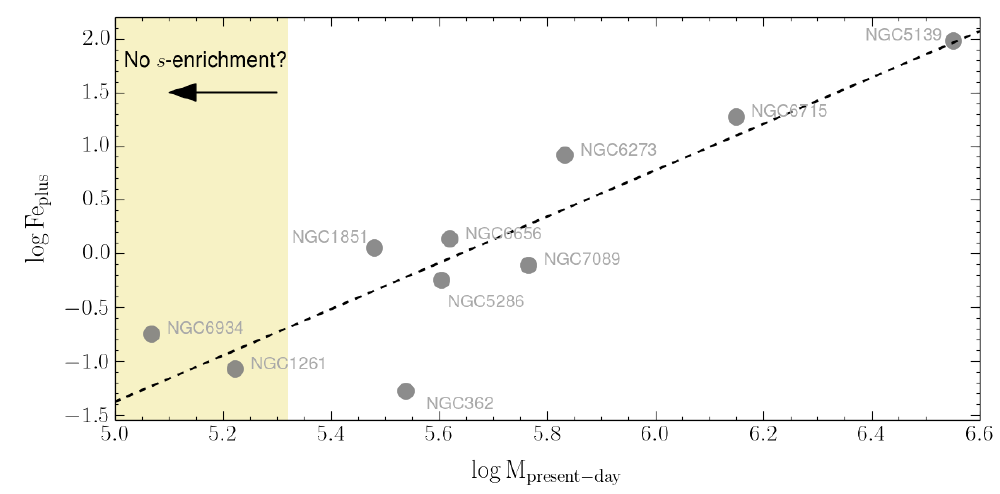
Figure 9. Logarithm of the additional iron included in the metal richer stellar populations as a function of the logarithm present-day GC